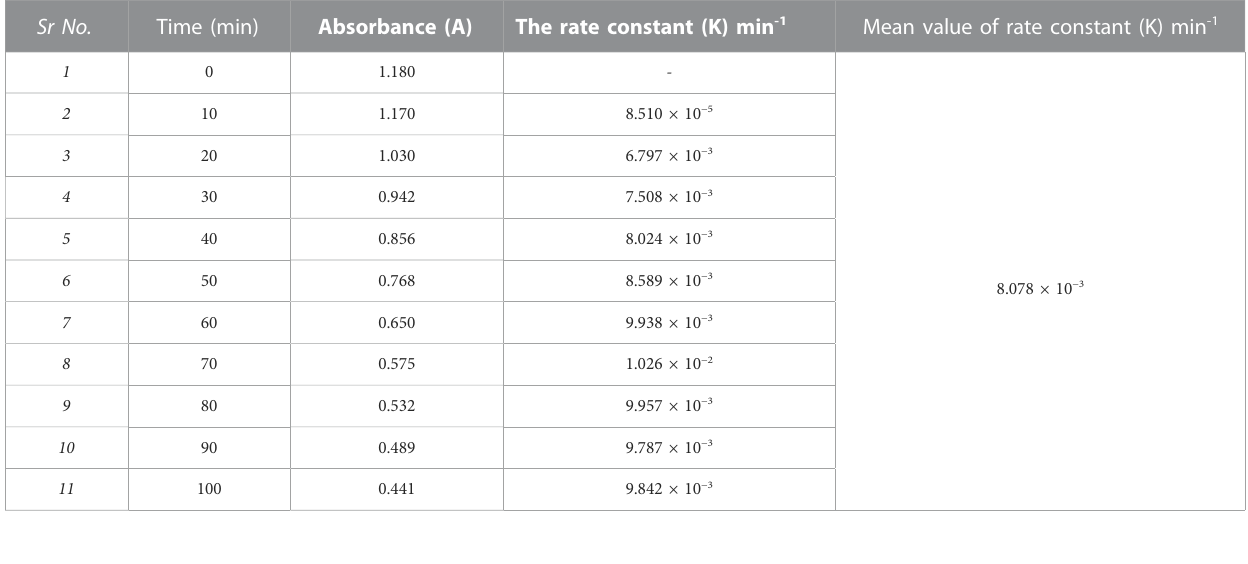
TABLE 3 Concentration dependence of the antibacterial activity of ZnO NPs against Escherichia coli. Compound Concentration Gram (+) bacteria Escherichia